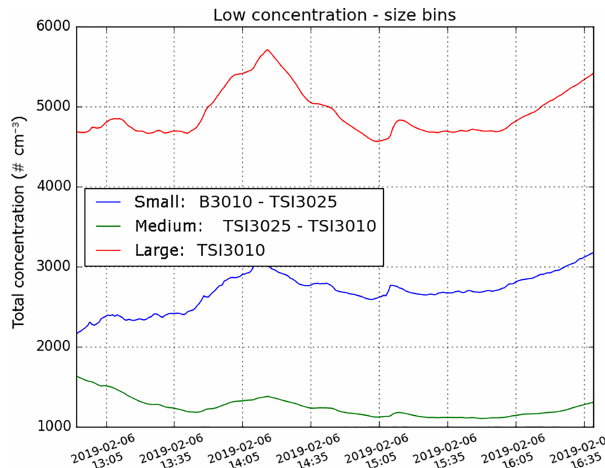
Figure 11. The B3010 in a CPC